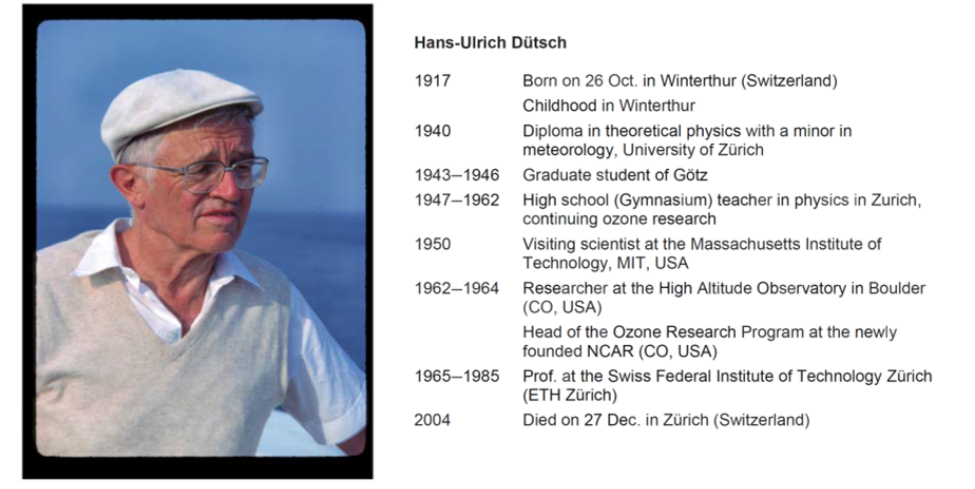
Figure 6. Biography of Hans-Ulrich